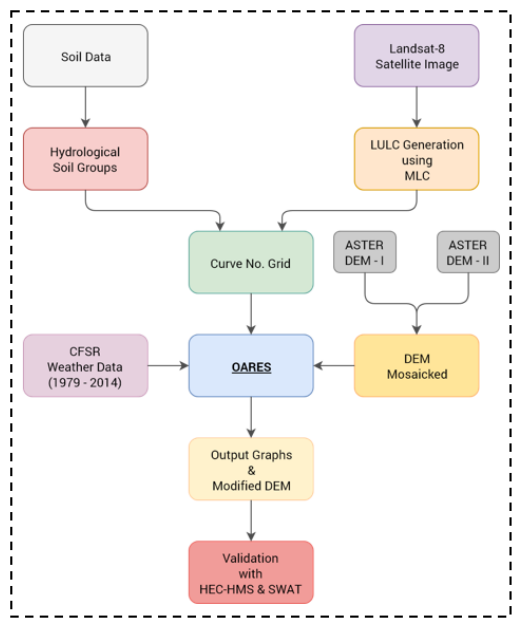
Figure 2. Proposed Methodology for OARES